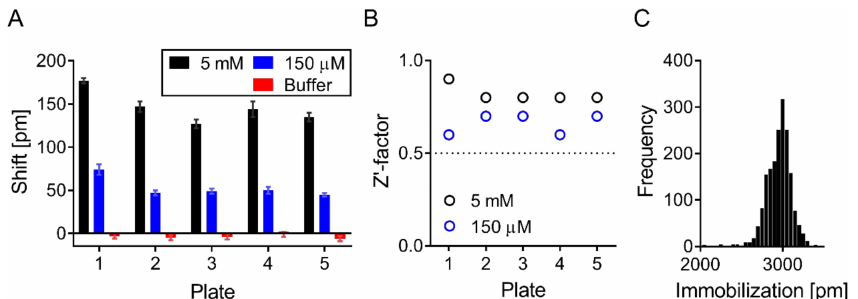
Figure 4. Screening statistics. Suramin at 5 mM and 150 µ M was used as positive control, and buffer as negative control during screen. ( A ) Suramin gave a mean shift ( ± SD) of 146 ± 17 and 53 ± 11 pm at 5 mM and 150 µ M, respectively. ( B ) Z (cid:48) -factors across all plates were >0.5. ( C ) Majority of wells had high ApoE4 immobilization levels, with mean ± SD immobilization levels of 2921 ± 86 pm. Only five biosensors had low ApoE4 immobilization levels (<1800 pm), and were excluded from data analysis. Out of the 707 screened compounds, 59 met the criterion to be considered a hit (i.e., response greater than fivefold above the median absolute deviation of the sample median; Figure 5A). Of these, 45 compounds were prioritized based on quantitative response and chemical attractiveness, and were tested in concentration response assays on the Corning Epic. Fourteen of these hits gave full or partial binding curves (Figure 5C and Supplementary Figure S4) and were further evaluated in the secondary